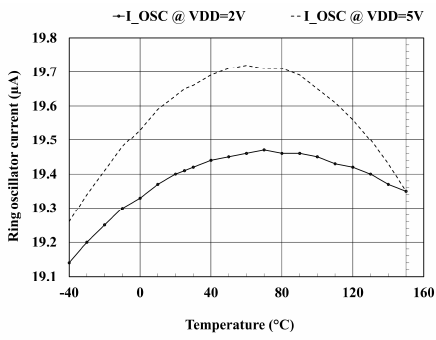
Figure 9. Ring oscillator quiescent current variation with temperature and VDD.